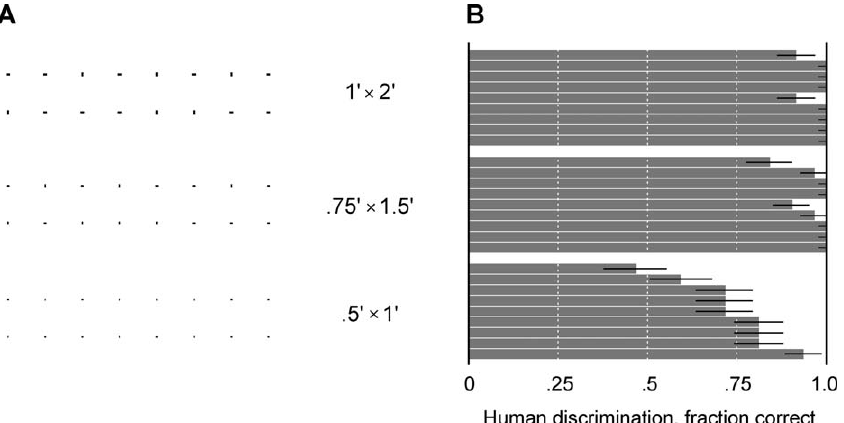
Figure 2. The Discrimination Task (A) Tiny horizontal and vertical stimuli, sized to subtend 0.5 3 1, 0.75 3 1.5, and 1 3 2 arcmin 2 when viewed at a distance of 88 cm. (B) Performance of nine human participants on this task, measured by the fraction of correct guesses out of 32 trials. Error bars represent the